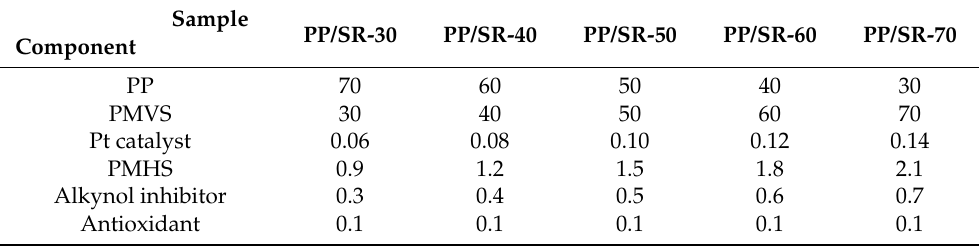
Table 1. Formulations of the polypropylene (PP)/silicone rubber (SR) thermoplastic vulcanizates (weight ratio). Sample PP/SR-30 PP/SR-40 PP/SR-50 PP/SR-60 PP/SR-70